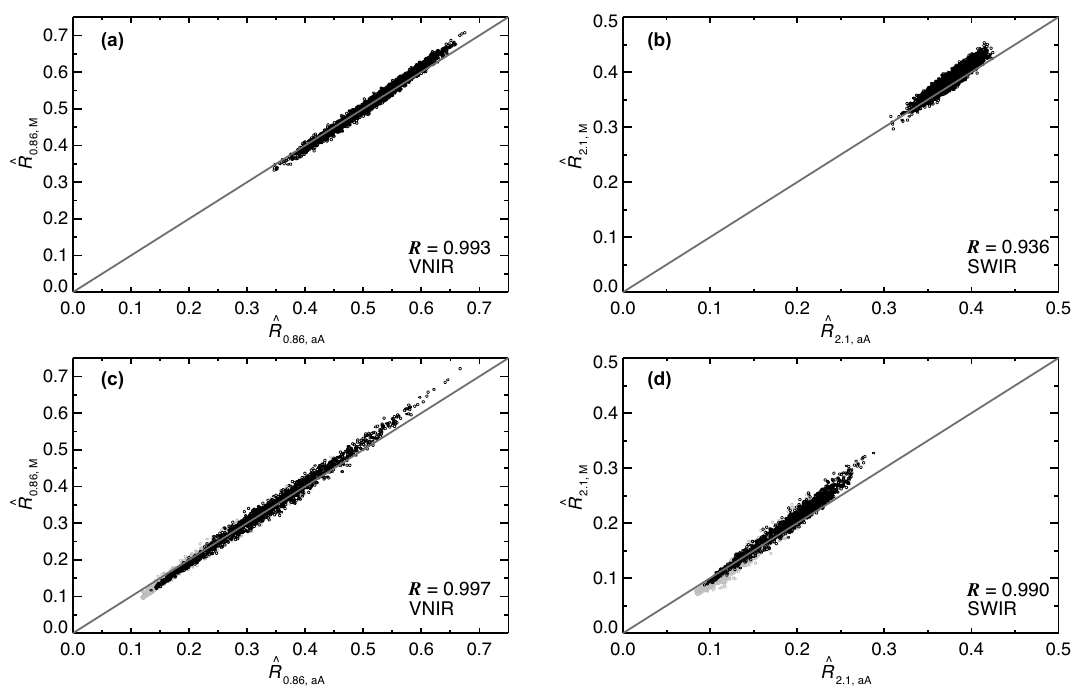
Figure 10. (a) Scatter plot of atmospherically corrected MODIS reflectances ( b R 0 . 86 , M ) in the VNIR as a function of co-located, atmospher- ically corrected ASTER reflectances ( b R 0 . 86 , aA ) in the VNIR. The gray diagonal line represents the 1 : 1 line. Overcast (partially cloudy) pixels are indicated in black (gray) color. Data are from observations on 13 May 2003 (C14). (b) Same as (a) but for b R 2 . 1 , M and b R 2 . 1 , aA sampled in the SWIR. (c) – (d) Same as (a) – (b) but for observations on 10 June 2005